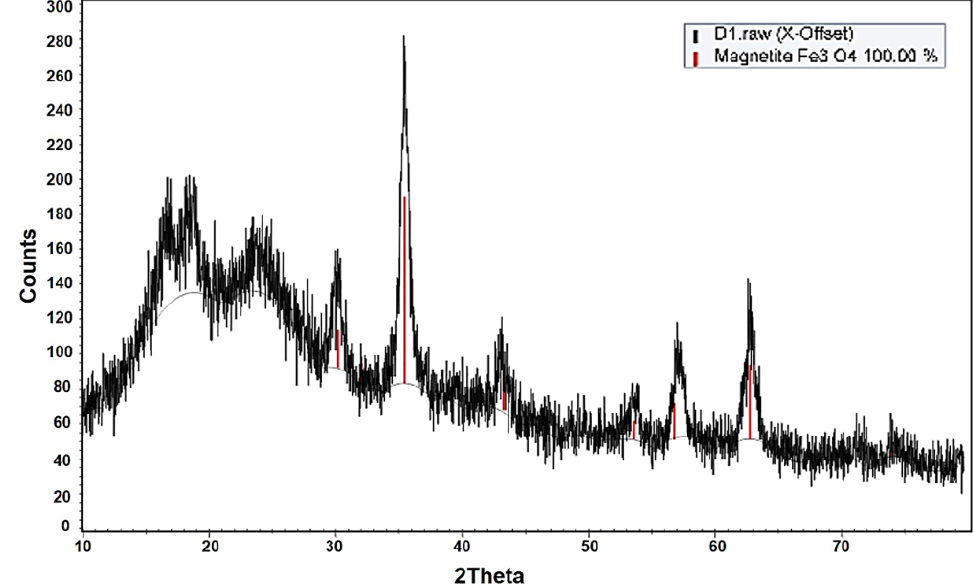
Figure 3. X-ray diffraction (XRD) result of PEG–starch–IONPs. Magnetite peaks are displayed as red in the profile.